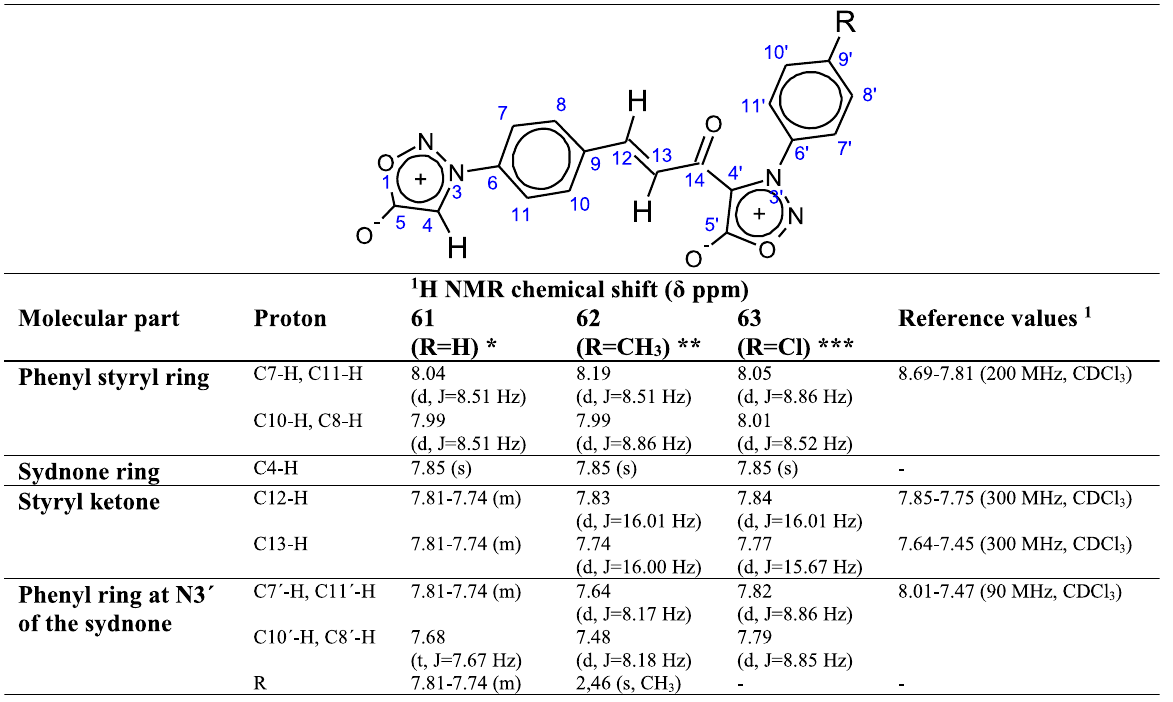
Table 6 1 H NMR spectral data of compounds 61 –